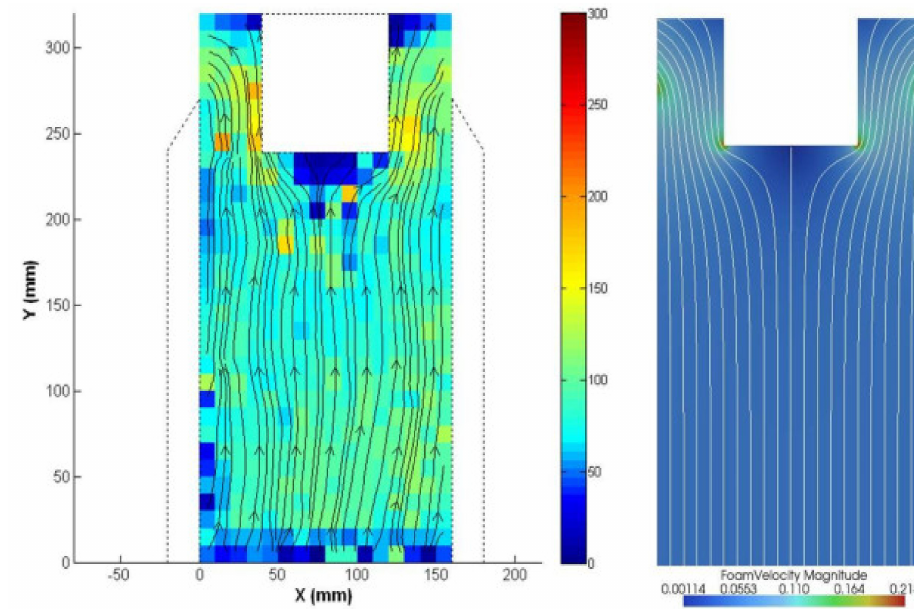
Figure 17. Bubble streamlines from a rectangular crowder [6].